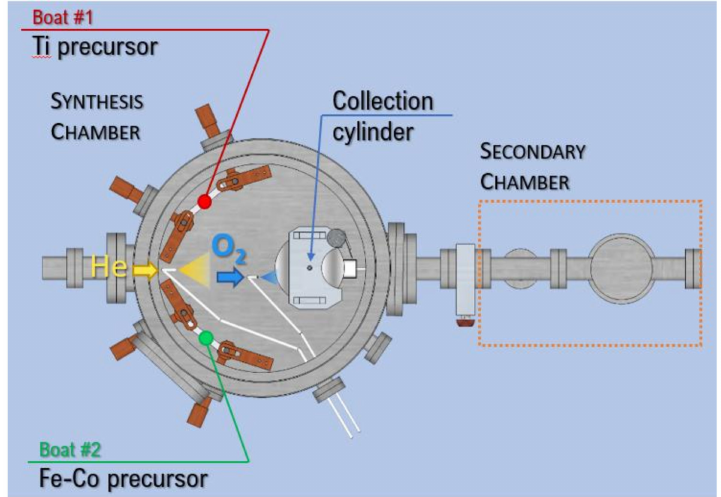
Figure 1. Top view of the GPC